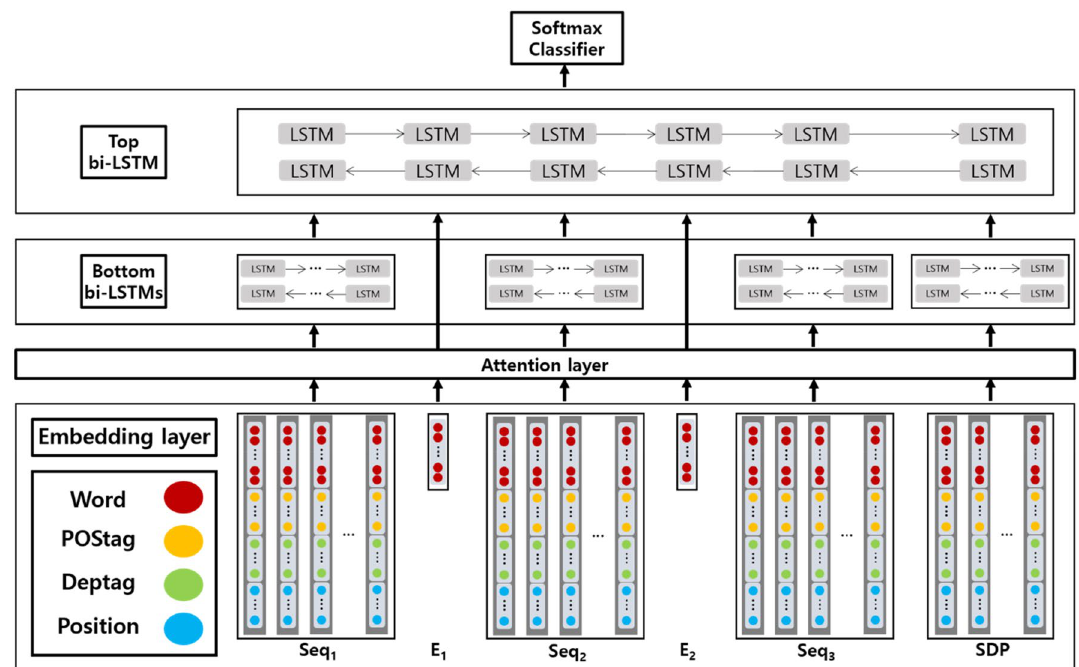
Figure 2. The overview of hierarchical long short-term memory model in this study. Words, part of speech for words, dependency tags for words, and relative positions to entities for words are used as features in the model. The model consists of embedding layer, attention layer, bottom LSTM, top LSTM, and softmax classifier. As input, the phrase before the first entity ( Seq 1 ), the first entity ( E 1 ), the phrase between two entity ( Seq 2 ), the second entity ( E 2 ), the phrase after the second entity ( Seq 3 ), and shortest dependency path (SDP) are entered into the